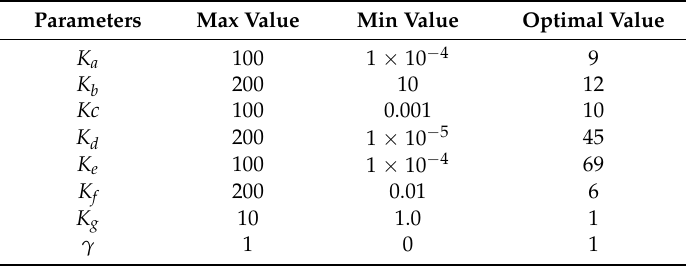
Table 1. Parameters of the weight function and optimal values.